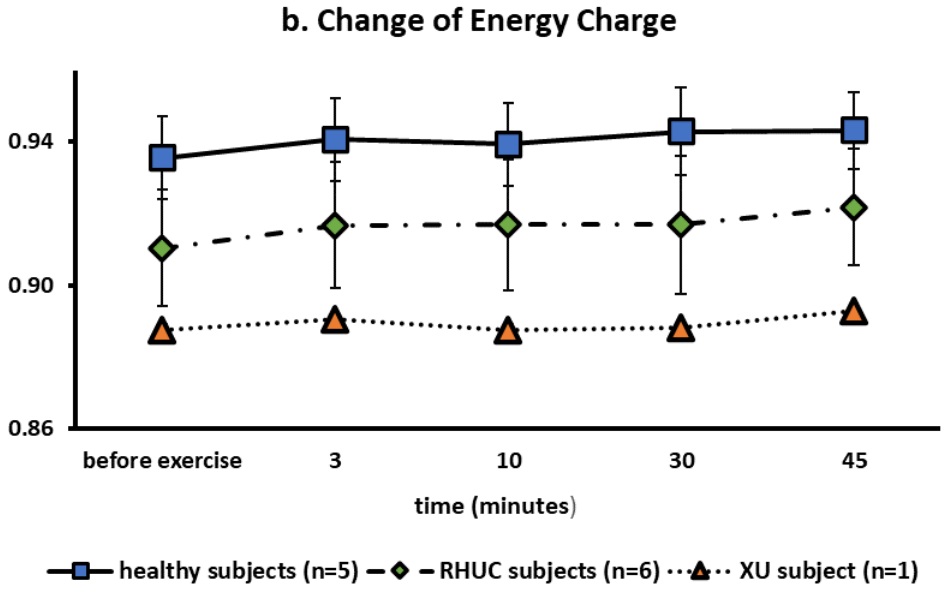
Figure 6. ( a ): Changes of ATP in red blood cells following semi-ischemic forearm exercise test. ( b ): Changes of Energy Charge following semi-ischemic forearm exercise test.